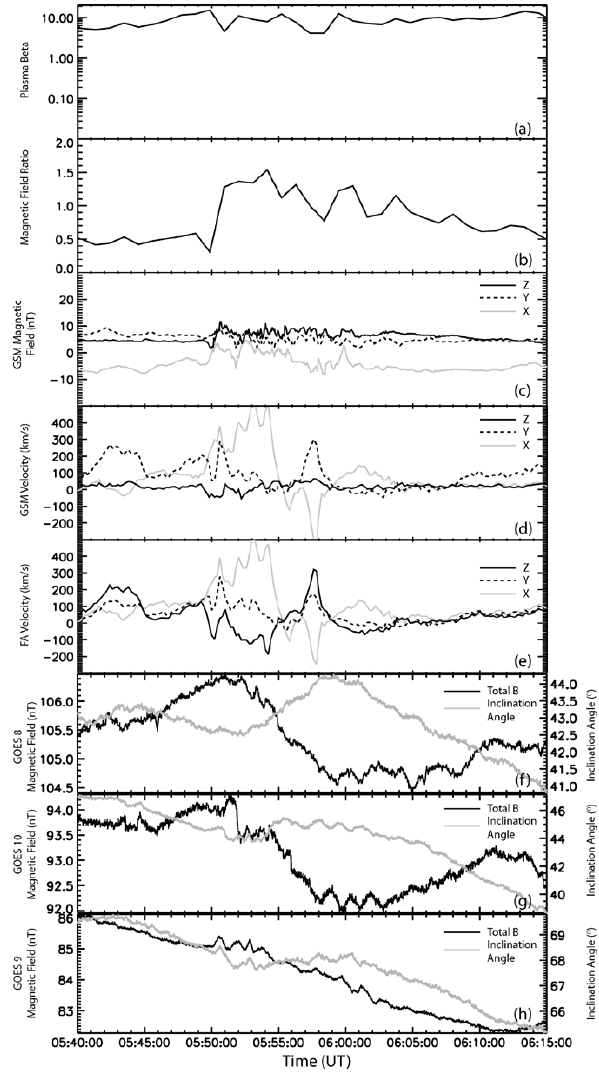
Fig. 2. In-situ and derived observations from Geotail for the pe- riod 05:45–06:15UT. (a) Ion-plasma beta observed during the BBF. (b) The magnetic field ratio (left y-axis), the ratio of B z to vector sum of B x and B y . (c) The GSM vector magnetic field. (d) The GSM plasma velocity and (e) plasma velocity in a field-aligned (FA) coordinate system. See text for details. (f) – (h) The total magnetic field and inclination angle (the angle between magnetic field vector and z-axis) at GOES-8, GOES-10 and GOES-9,